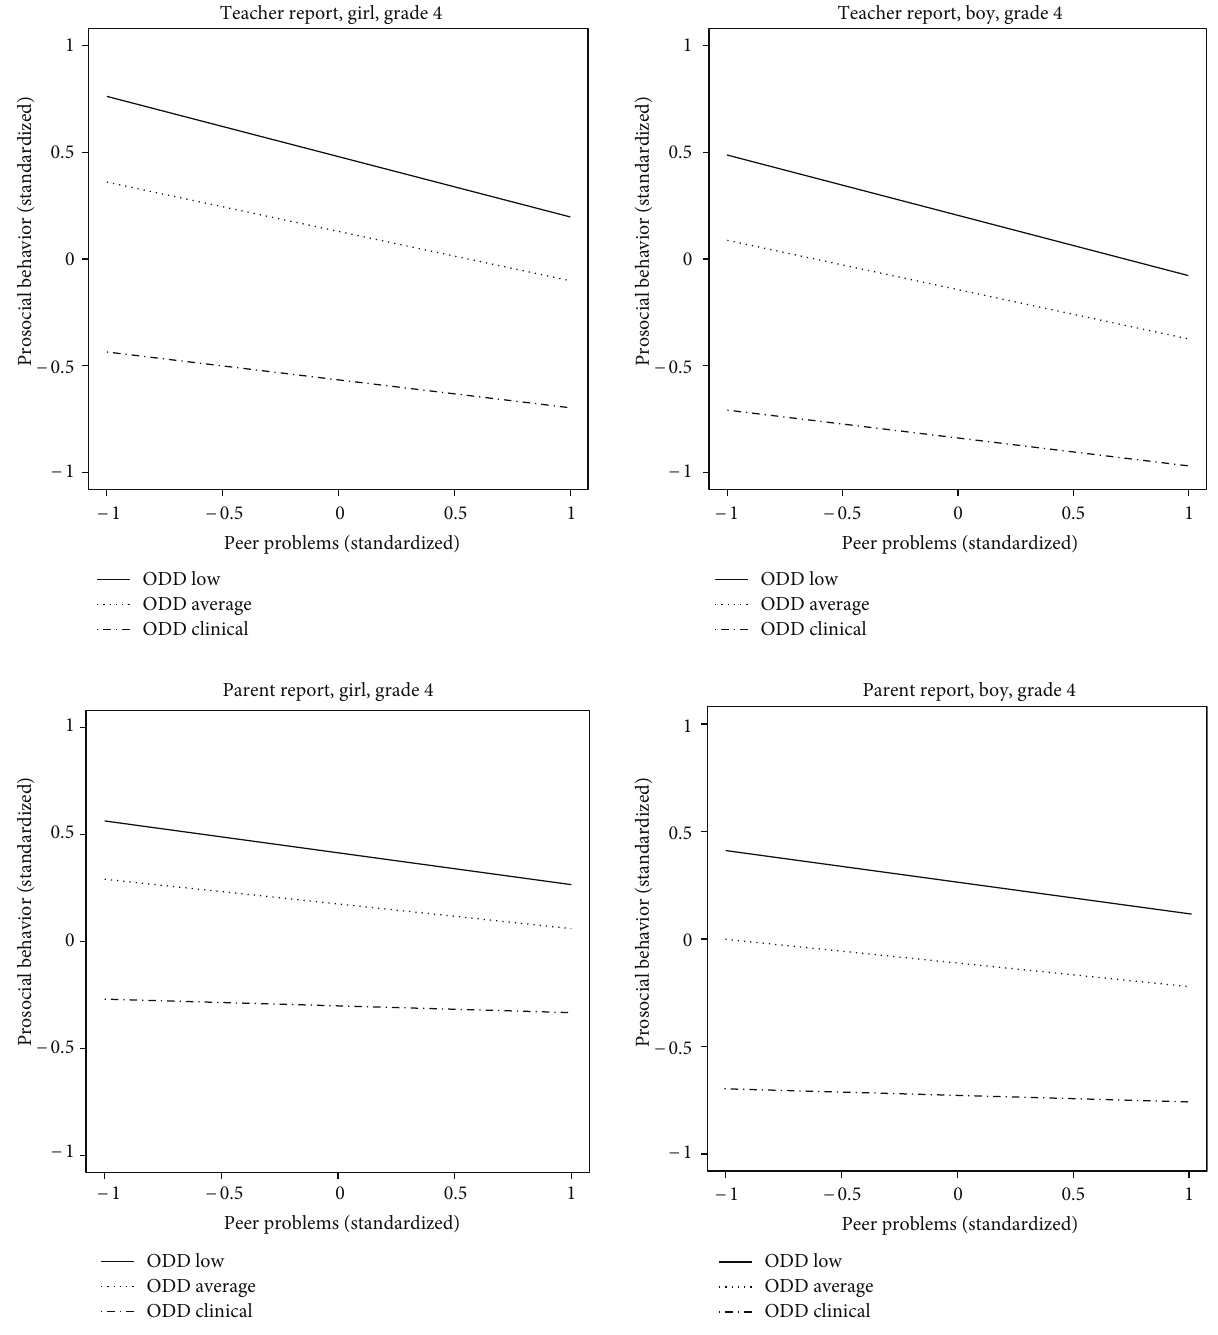
F 1: Graphical illustration of the moderator effect of ODD on the relationship between peer problems ( ( -axis). Different plots were made for teacher and parent report, as well as for girls and boys. e effects shown are those found for children in grade 𝑦𝑦